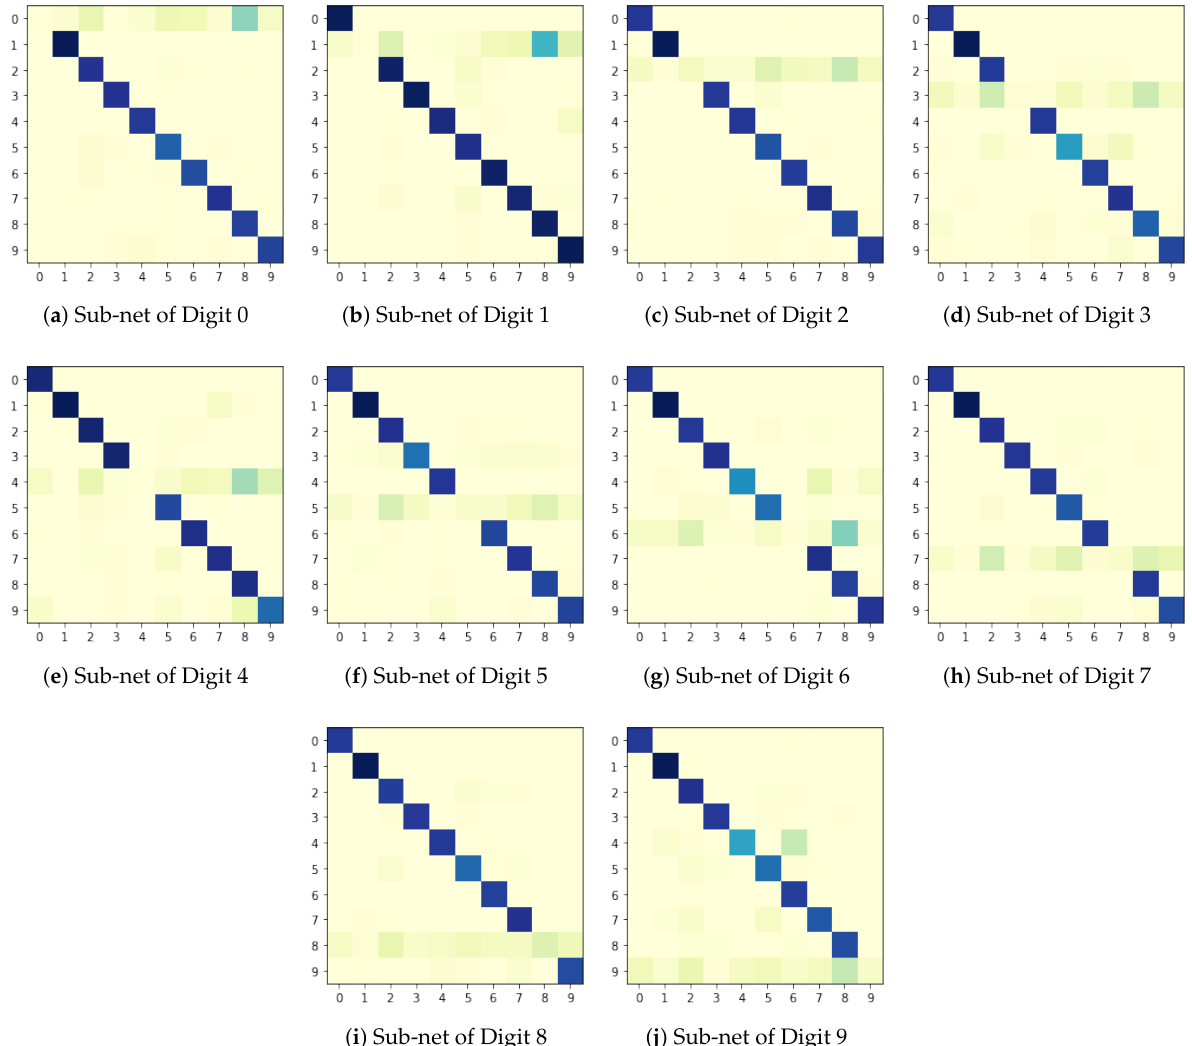
Figure 4. Results of different class pathways when applying an ablation study on the MNIST